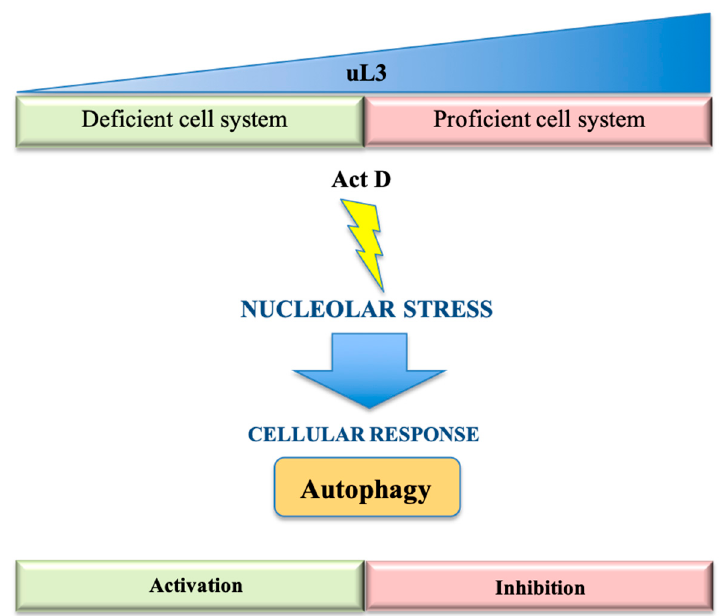
Figure 2 . Effect of uL3 (RPL3) status on autophagy. The nucleolar stress response upon Act D treatment depends on uL3 status. Reduced uL3 levels cause a cellular response employing autophagy induction, while increased uL3 amounts inhibit this process.